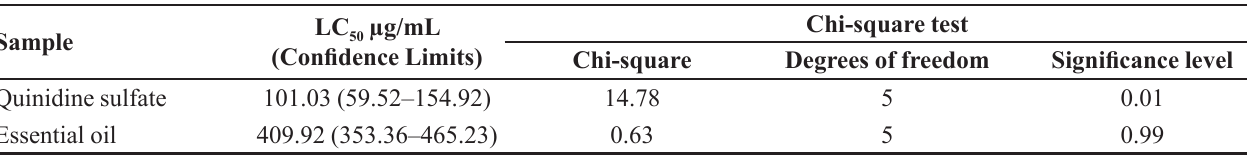
TABLE III - Preliminary in vitro toxicity against Artemia salina Sample